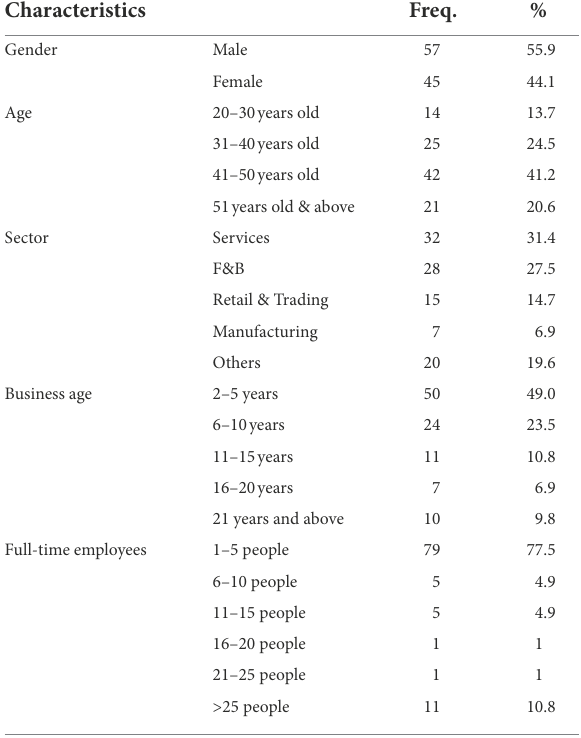
factors; third, parameters are estimated; and fourth, inference is tested by bootstrapping (Henseler et al., 2016).